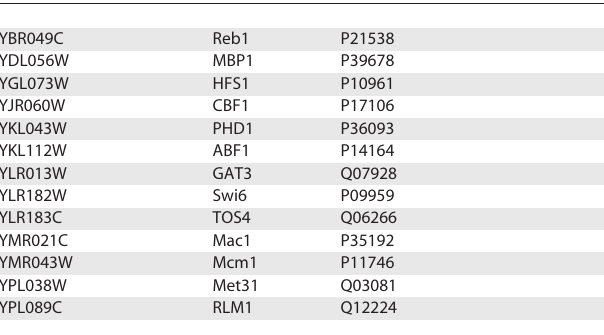
Table 5. Swiss-Prot Accession Numbers for Genes and